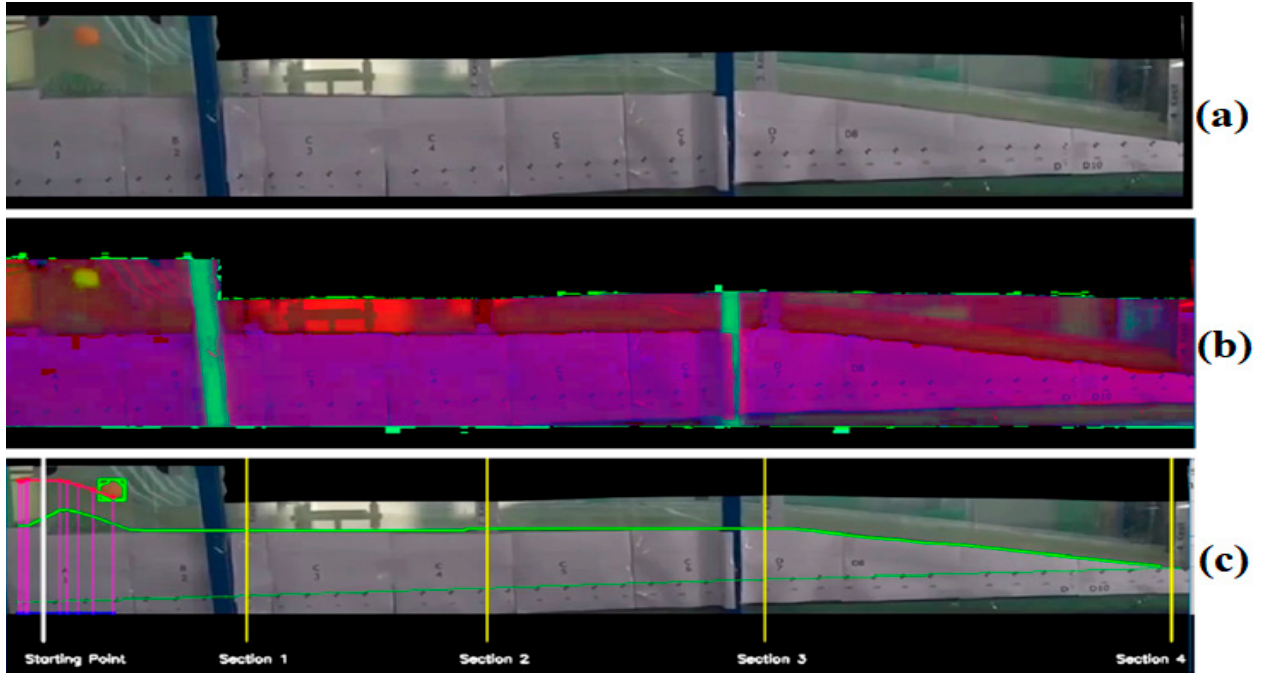
Figure 11. The OpenCV code stages: ( a ) reading current video image; ( b ) image filtering for floating object detection and tracking; ( c ) calculation of the water depth according the tracked object (The yellow lines show the cross-section locations, the green line the base of the spillway model).